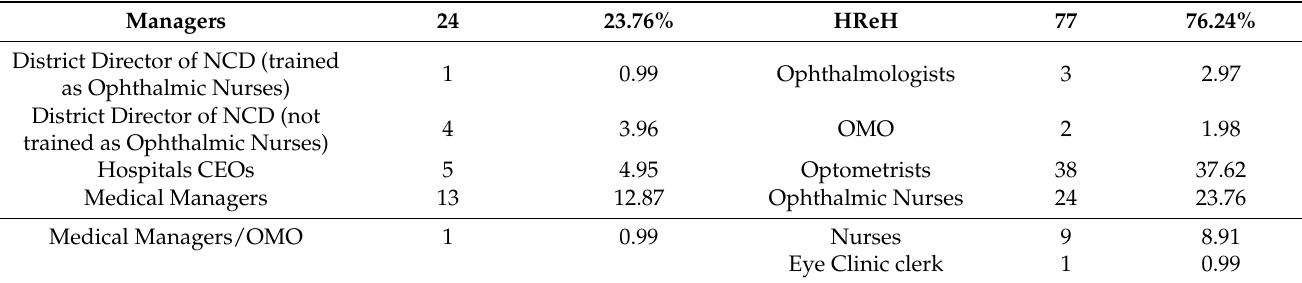
Table 1. Distribution of managers and